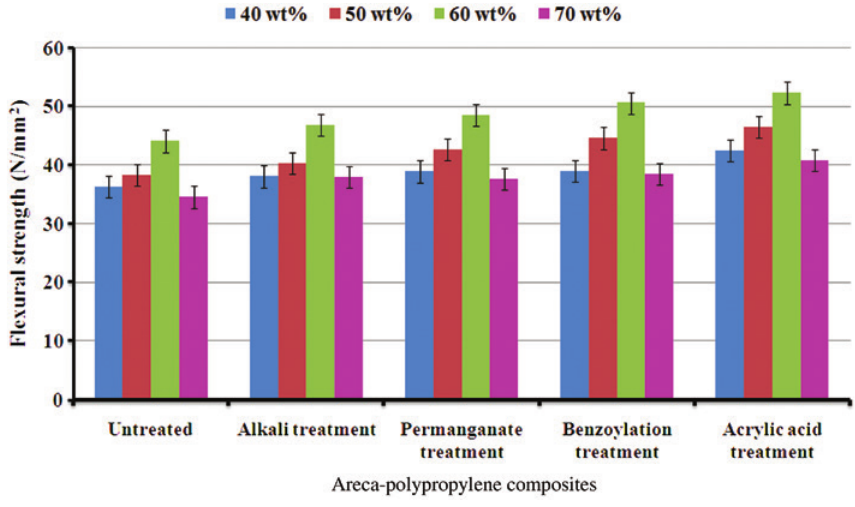
Figure 3: Flexural strength of areca-polypropylene composites with different fiber